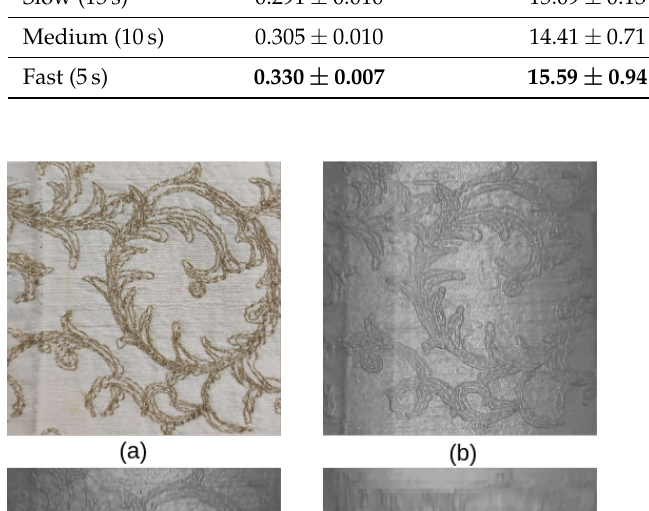
Table 1. Comparison of the captured tactile map with the corresponding textured fabric top-view, for the three motion velocities: slow (15s), medium (10s), and fast (5s). SSIM